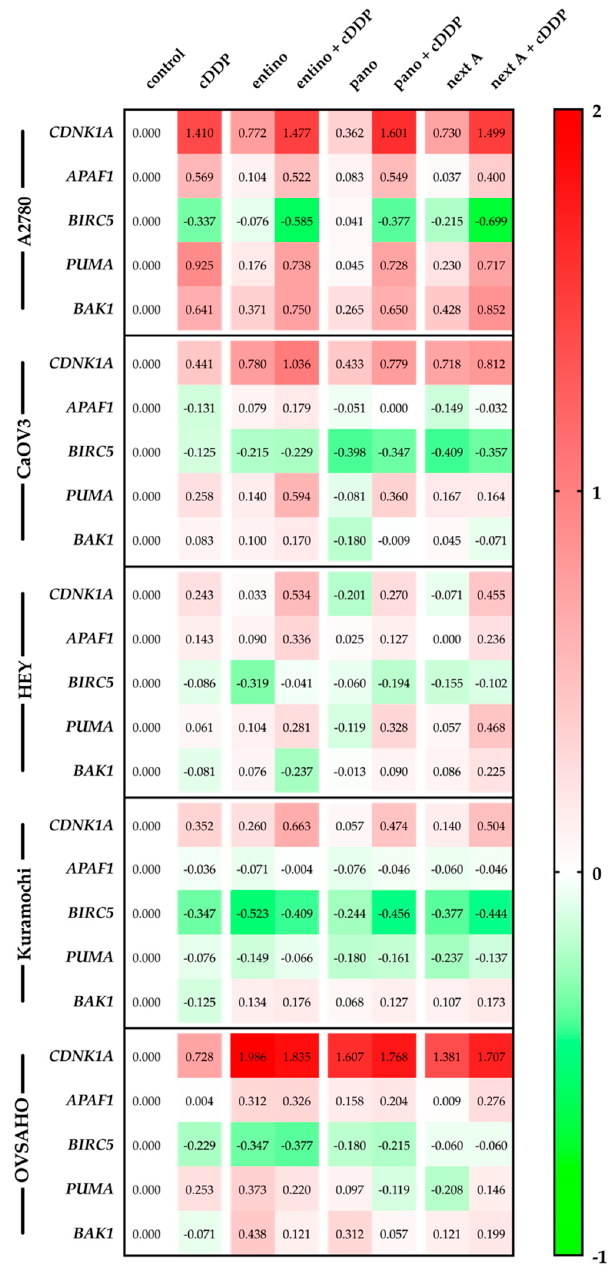
Figure 9. Gene expression data were obtained by RT-PCR and analyzed according to Vandesompele [40]. Cells were pretreated with concentrations of HDACi shown in Table 4 for 48 h followed by treatment with cisplatin for 24 h in an IC 50 concentration. Data shown are normalized to endogenous control gene expression of HPRT1 (hypoxanthine-guanine phosphoribosyltransferase), TBP (TATA binding protein), and GUSB (beta-glucuronidase) and rescaled to cell line specific control (72 h incubation with vehicle). Data are shown on a decadic logarithmic scale. Negative values marked in green show a lower expression compared to cell line specific control. Positive values marked in red show a higher expression compared to cell line specific